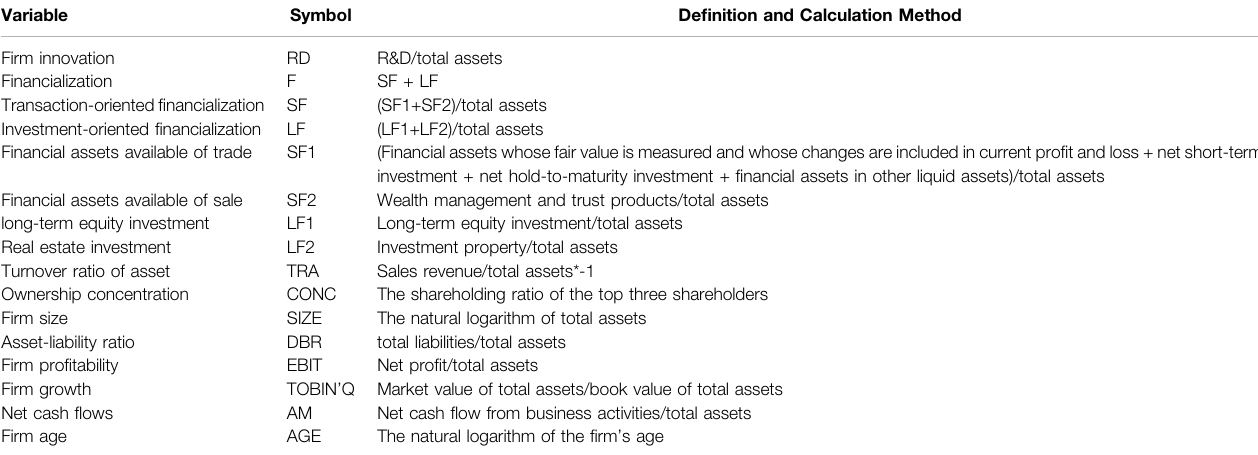
TABLE 1 | De fi nitions of variable and calculation method. Variable